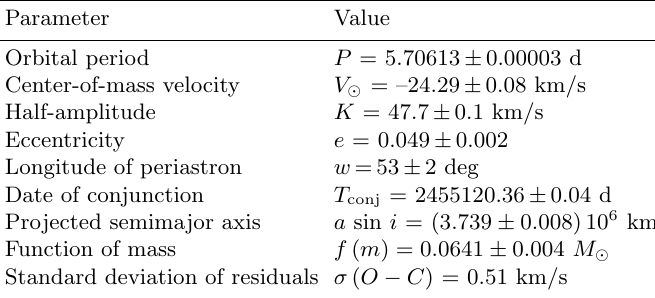
Table 2. Orbital elements of BD+20 5152.